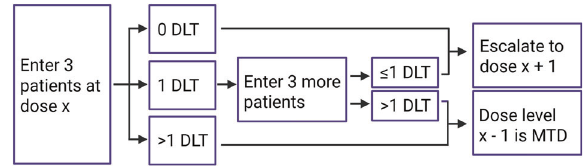
Fig. 1 The 3 + 3 phase I trial design. DLT dose-limiting toxicity, MTD maximum tolerated